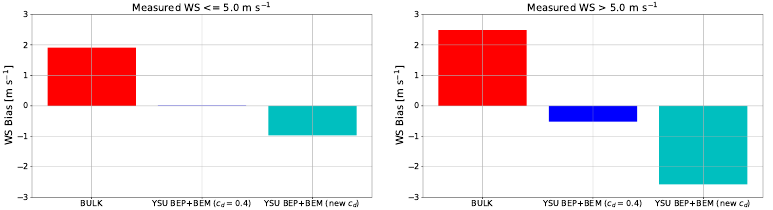
Figure 15. WS bias stratified by whether the measured WS at the TCEQ station is less or greater than 5 m s − 1 for each of the three simulations.